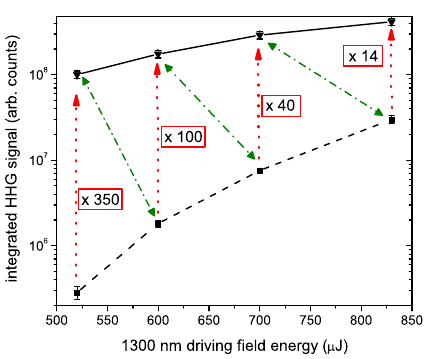
Figure 1. HHG yields in Krypton for single colour fields (dashed black line) and two colour fields (solid black line). The energy in the strong, 1300 nm field was varied between 520 μ J and 830 μ J (corresponding to intensities between 6 . 3 × 10 13 Wcm − 2 - 1 . 0 × 10 14 Wcm − 2 ), while the energy of the weak 800 nm beam was fixed at 120 μ J (intensity 2 × 10 13 Wcm − 2 ). Red arrows highlight the enhancement factors for each input energy, reaching up to two orders or magnitude ( > 300). The green dash-dotted lines link the HHG yields, for comparative purposes, from single colour fields and two colour fields with approximately the same total